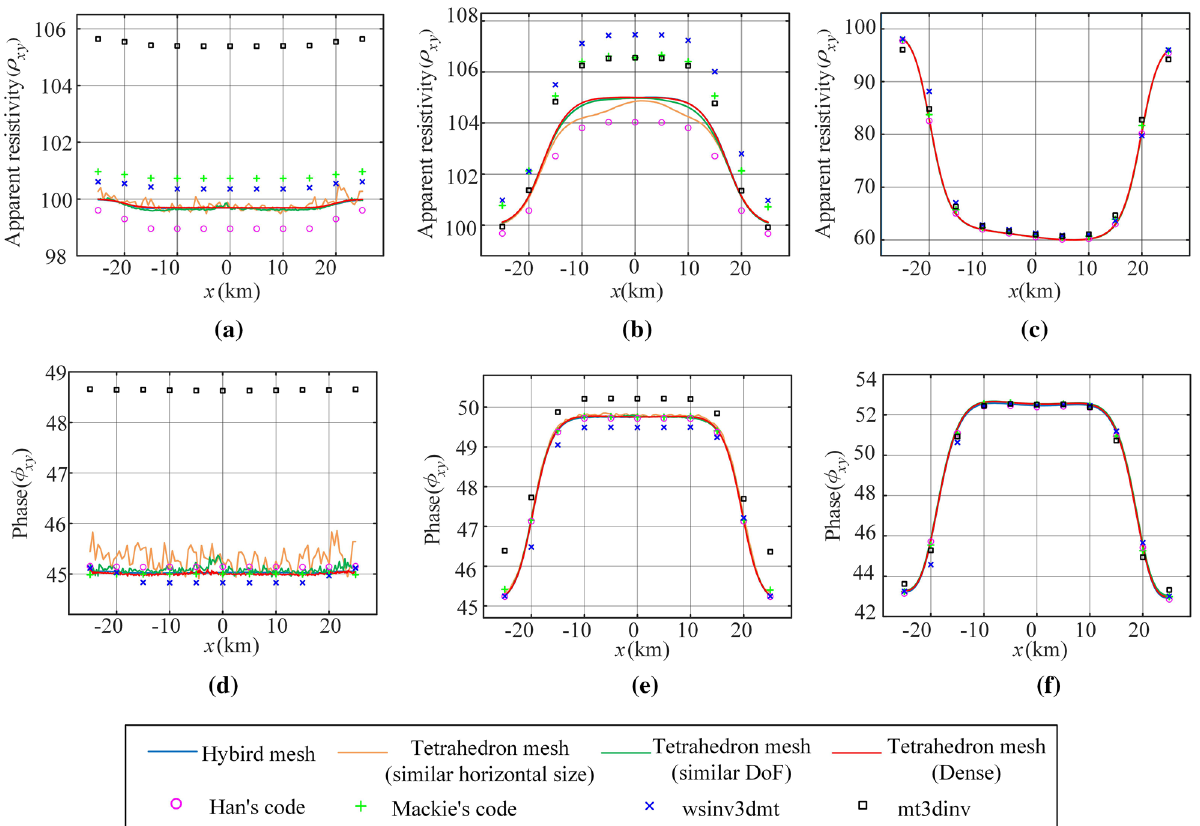
Figure 11. Calculation results of the DTM1 model. ( a ) and ( d ) represent the apparent resistivity result and phase result at a frequency of 10 Hz, ( b ) and ( e ) represent the apparent resistivity result and phase result at a frequency of 1 Hz, and ( c ) and ( f ) represent the apparent resistivity result and phase result at a frequency of 0.1 Hz. The responses of Nam’s code are obtained with FEM 43 by Han/Lee 44 . The responses of Mackie’s code are obtained using the finite difference method by Mackie et al. 41 . The responses of wsinv3dmt 42 and mt3dinv are obtained by the FD codes 45 .